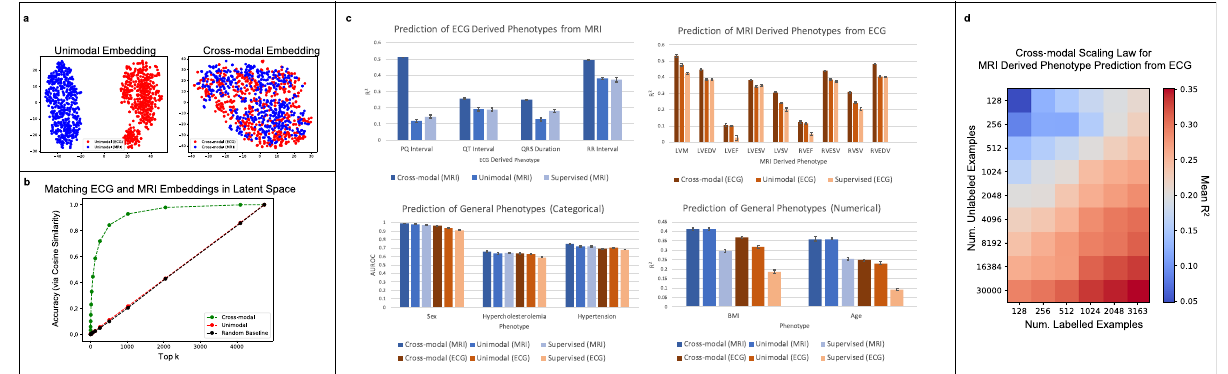
Fig. 2 | Improvement of phenotype prediction from cross-modal representa- tions over unimodal representations or supervised learning from the original modalities.a At-SNEvisualizationofthecross-modalembeddingsfortheECGand MRI samples demonstrates that the modality specifc embeddings are well-mixed, unlike the modality speci fi c embeddings obtained from the unimodal auto- encoders. b Ranking eachMRIbyitscosinesimilaritywithagivenECGinthelatent space, we visualize the accuracy that the ground truth MRI appears in the top k neighbors among 4752 test ECG-MRI pairs from the UK Biobank. c Kernel regres- sion on cross-modal representations outperforms kernel regression on unimodal representations and supervised deep learning methods on 4 different tasks: (1) prediction of ECG derived phenotypes from MRIs only ( n =4120, mean values are reported with error bars indicating one standard deviation); (2) prediction of MRI- derived phenotypes from ECG only ( n =4218, mean values are reported with error bars indicating one standard deviation); (3) prediction of general physiological